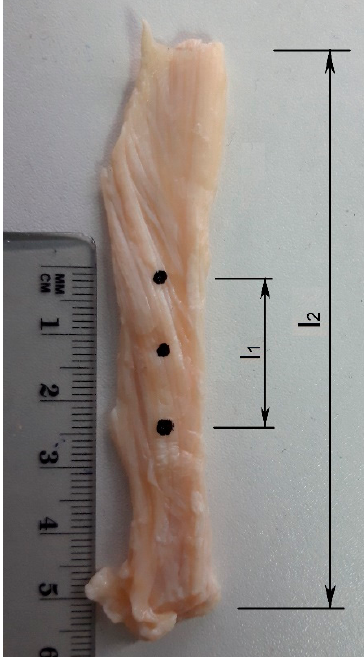
Figure 11. The marked specimen according to ISO 527-1:1993.